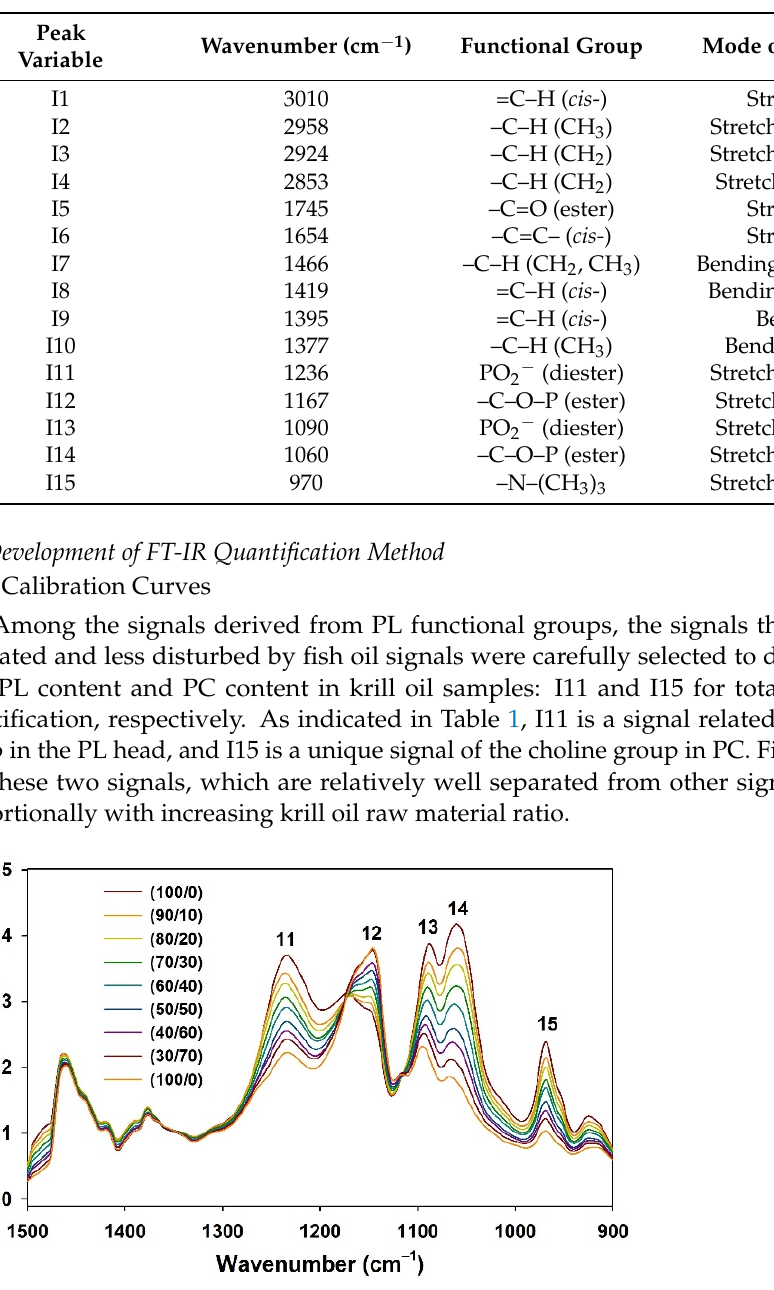
Table 1. Assignment of absorption signals in FT-IR spectrum of krill oil reference sample [1,36,37].